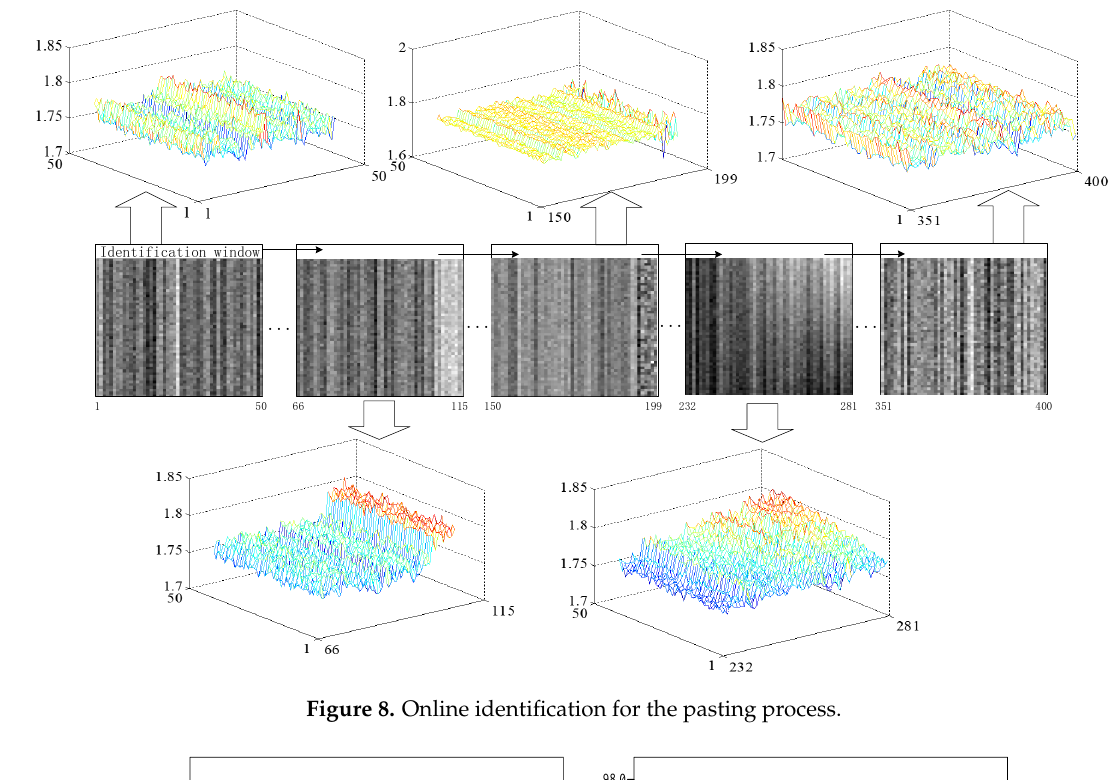
Figure 8. Online identification for the pasting process.